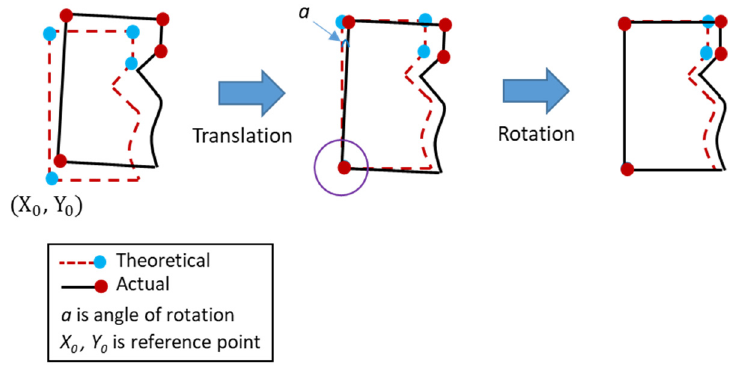
Figure 2. The translation and rotation of the measurement coordinates .